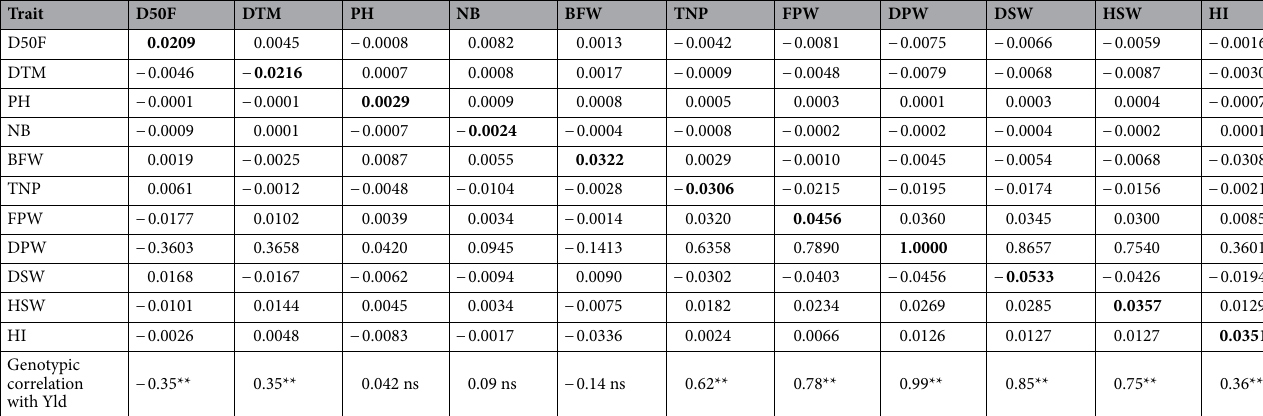
Table 8. The direct (diagonal) and indirect effects of 11 characteristics on pod yield in 30 V . subterranea genotypes. D50%F = days to 50% flowering, DTM = days to maturiity, PH = plant height (cm), NB = number of branches , BFW = biomass fresh weight (g), TNP = total number of pods, FWP = fresh pods weight (g), DPW = dry pods weight (g), DSW = dry seeds weight (g), HSW = hundred seed weight (g), HI = harvest index, and YLD = yield